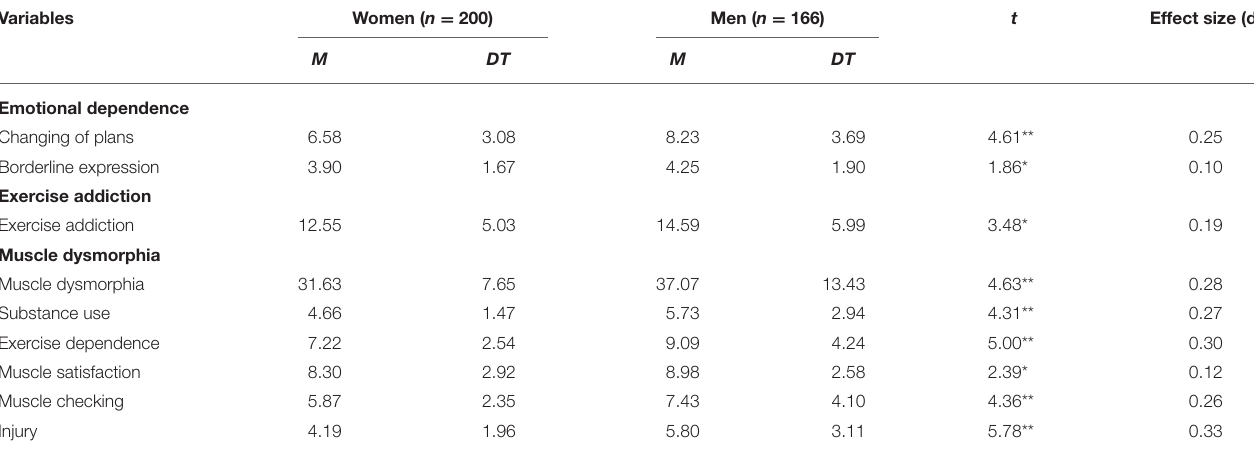
TABLE 2 | Differences according to sex in emotional dependence, attachment, exercise addiction, and muscular dysmorphia.